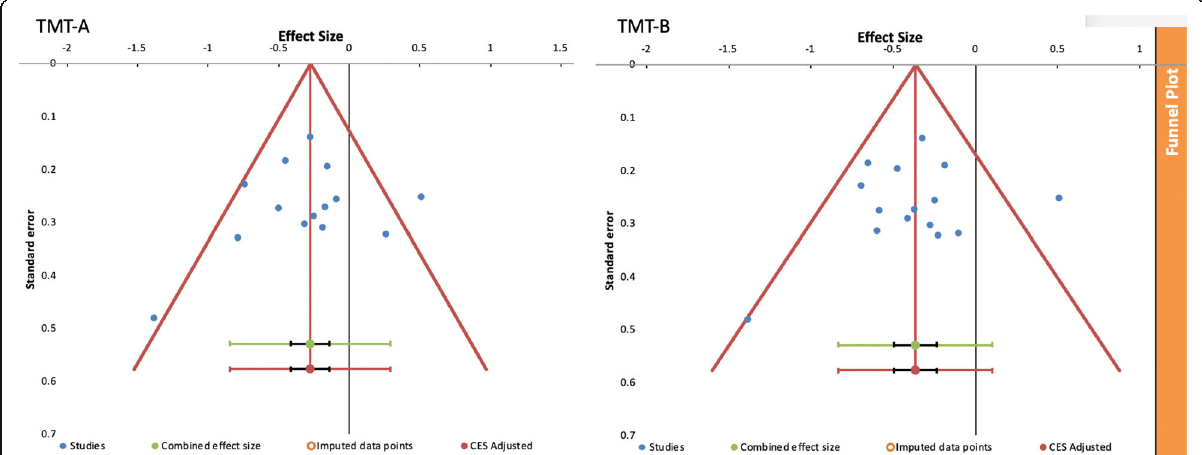
Fig. 4 Funnel plots of the studies in the TMT-A (left) and TMT-B (right) meta-analyses (represented by blue dots), with effect size (on the x-axis above) and standard error (on the y-axis). The combined effect size (green dot) with its confidence interval (black) and prediction interval (green) is also shown. The plots also show a vertical line (in red) that runs through the (adjusted) combined effect size (CES) and the related lower and upper boundaries of the confidence interval (red diagonal lines). The absence of imputed data demonstrates no risk of bias